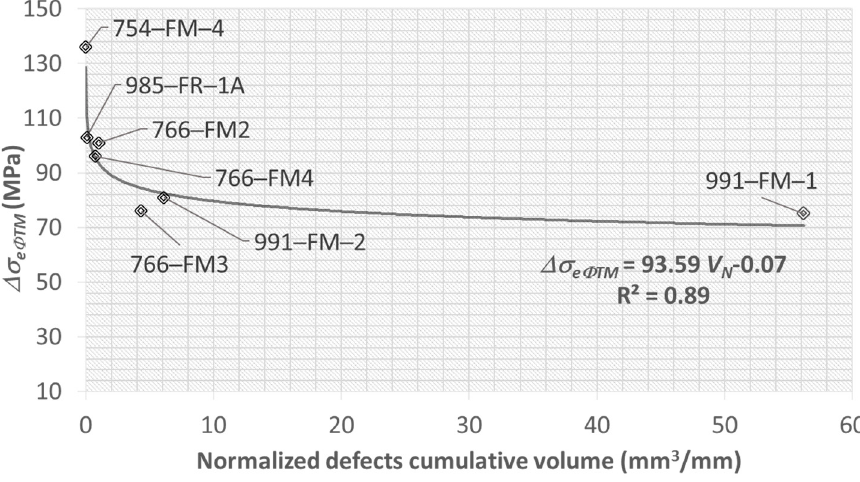
Figure 17. Fatigue strength ( Δ σ e Φ TM ) vs. normalized defects cumulative volume ( V N ) (type-C-1,